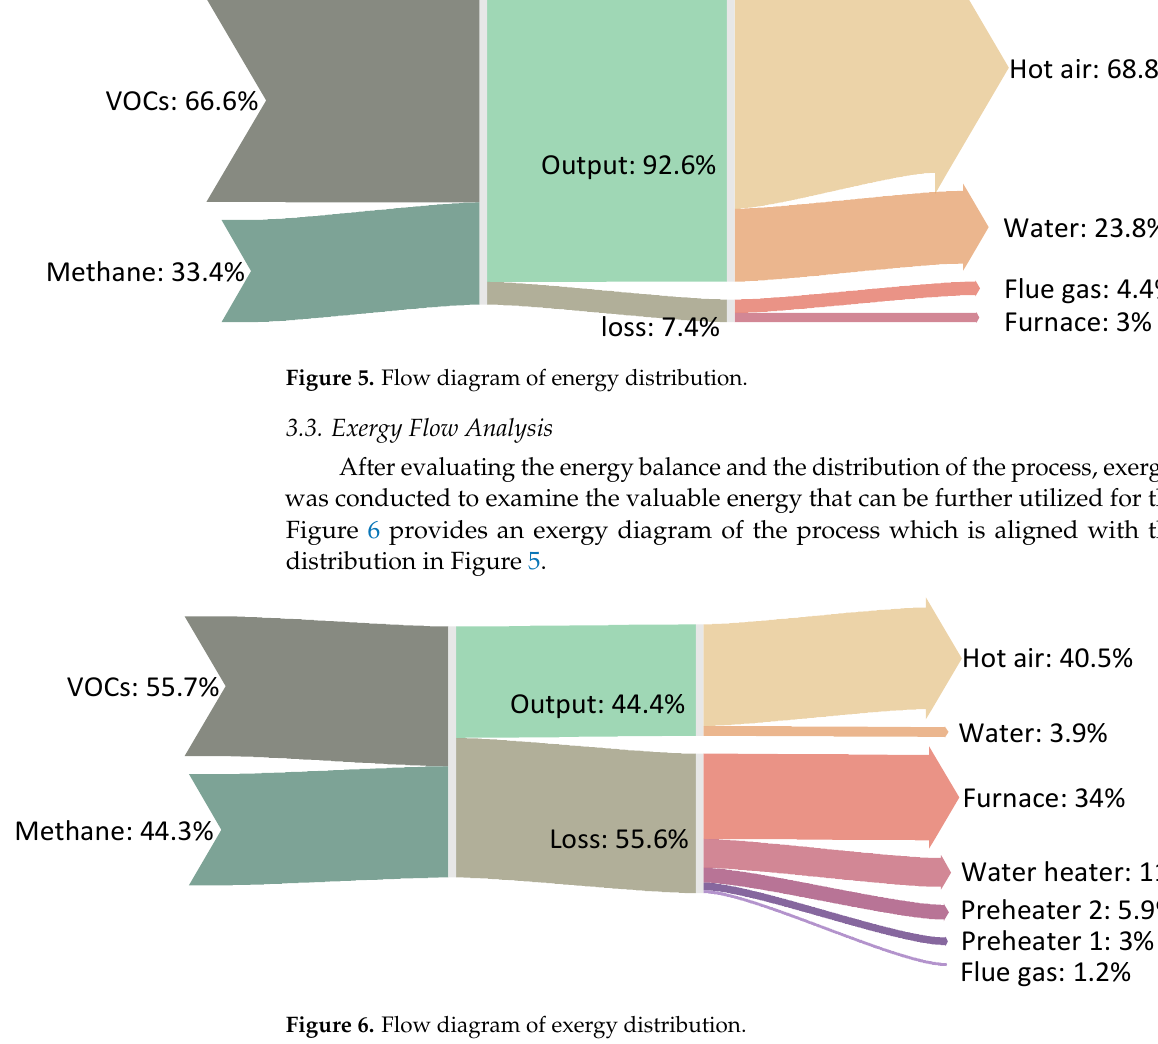
Figure 6. Flow diagram of exergy distribution.